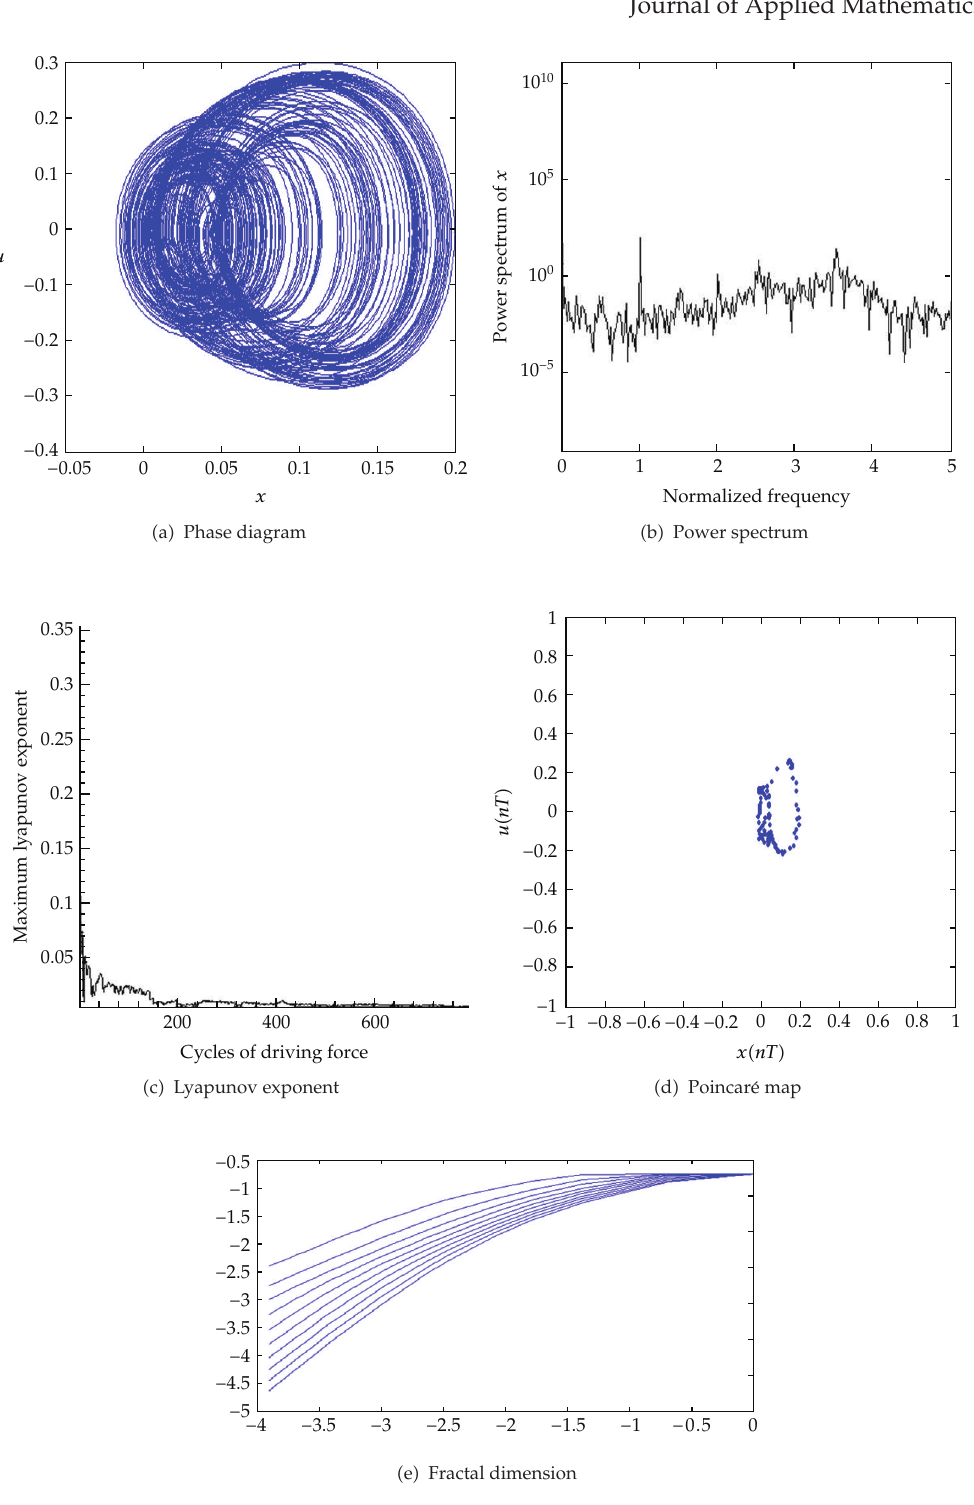
Figure 8: Simulation results obtained for rotor-bearing system with s (cid:8) 0.36 (cid:2) with rub-impact e ff ect (cid:3)